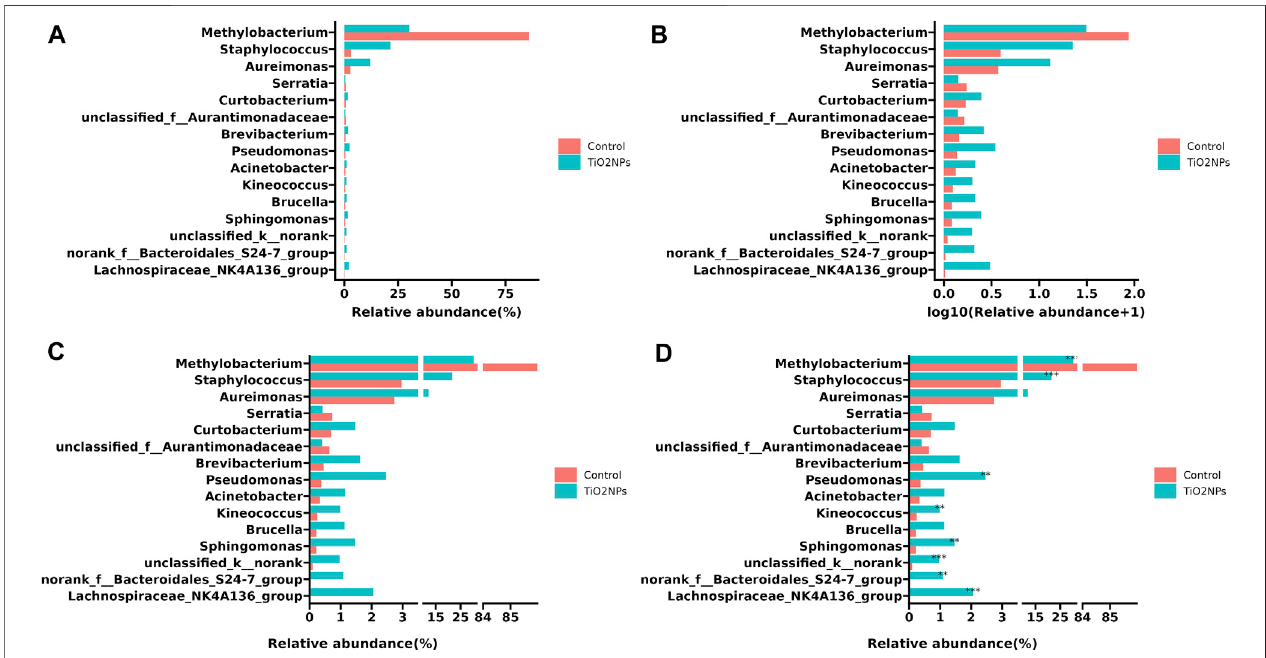
FIGURE 4 | Visualizing relative microbe abundances using bar charts to show the top 15 signi fi cant genera between two groups. (A) Ordinary bar chart that is dif fi cult to deal with outliers. (B) Bar chart with log transformation on the x -axis to remove skewness. (C) Bar chart with a gapped axis that can effectively deal with data of different magnitude. (D) . Superposed signi fi cant level layer to the gapped plot (C) . The example data was collected from a paper published in 2020 (Li et al., 2020).